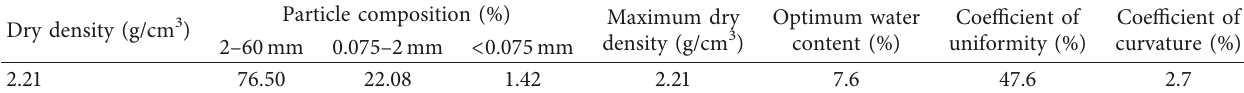
Table 1: Physical properties of the